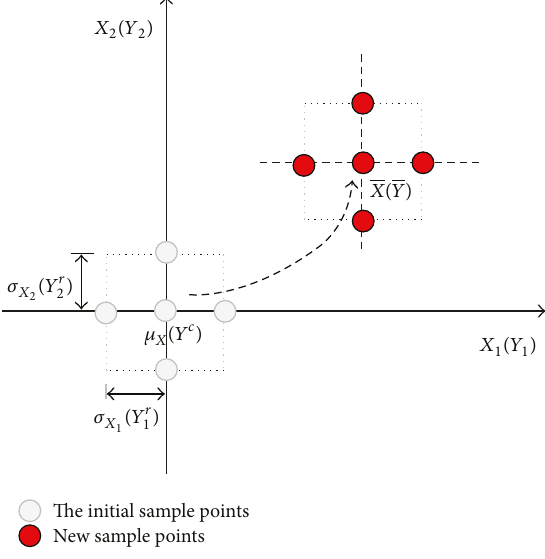
Figure 2: Processing of the sample points